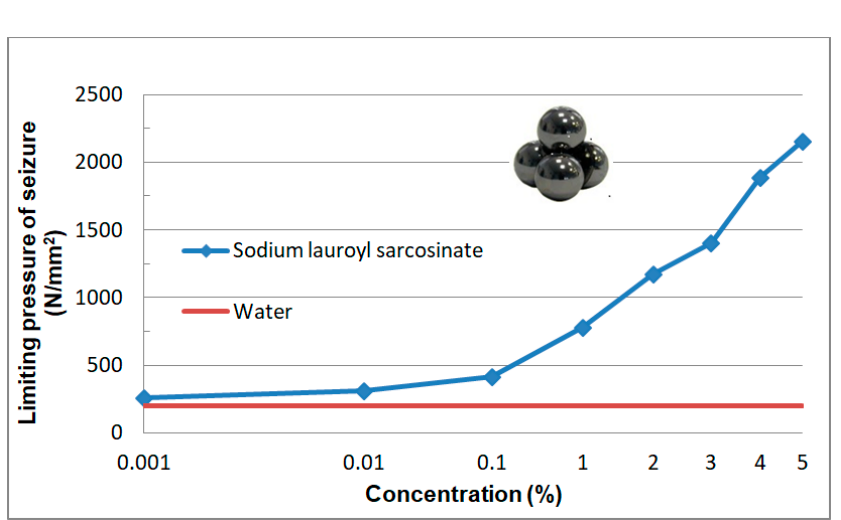
Figure 13. Dependence of limiting pressure of seizure p oz as a function of surfactant solution (c) in aqueous solution. Solid line describes p oz value for water (200 N/mm 2 ).